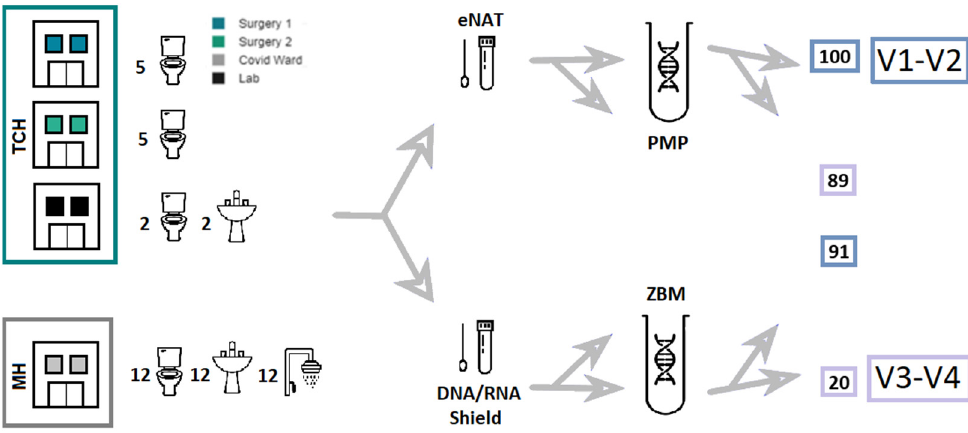
Figure 1. Specimen collection, preservation, and processing flow. The color of the boxes on the right of the image indicates how many samples from each workflow were ultimately sequenced with the corresponding primers.